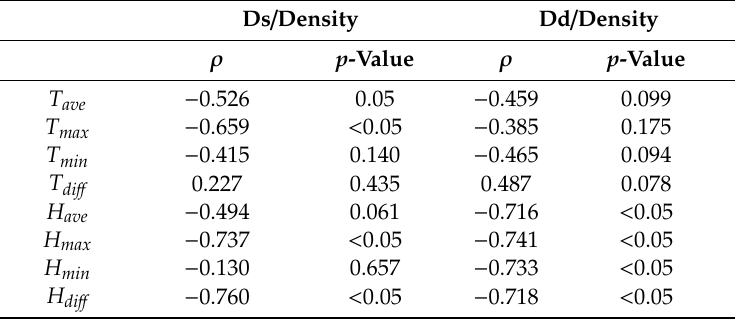
Table 4. Spearman’s rank correlation coe ffi cients and p -values for spread and decay durations normalized by population